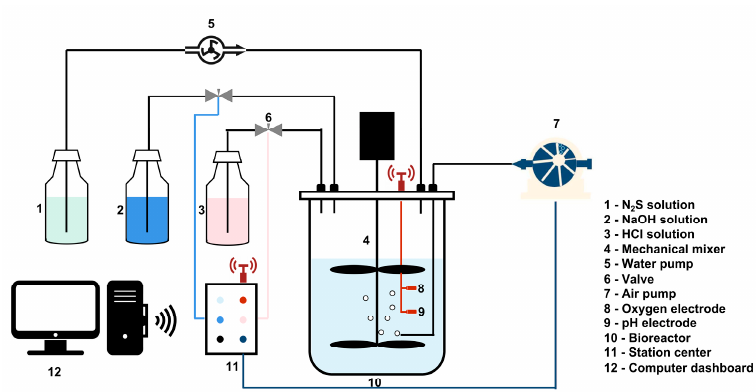
Figure 1. Scheme of the experimental setup for biological sulfide oxidation.